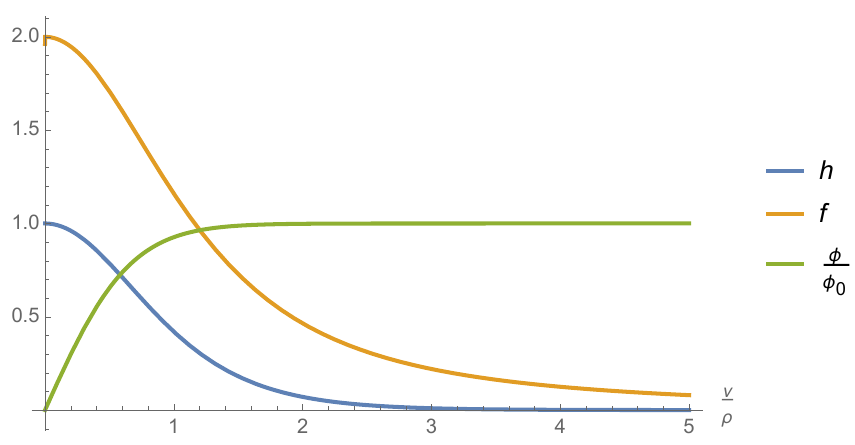
Figure 8 . Graph of the exact double BPS vortex solutions for ( q; l ) = (3 ;